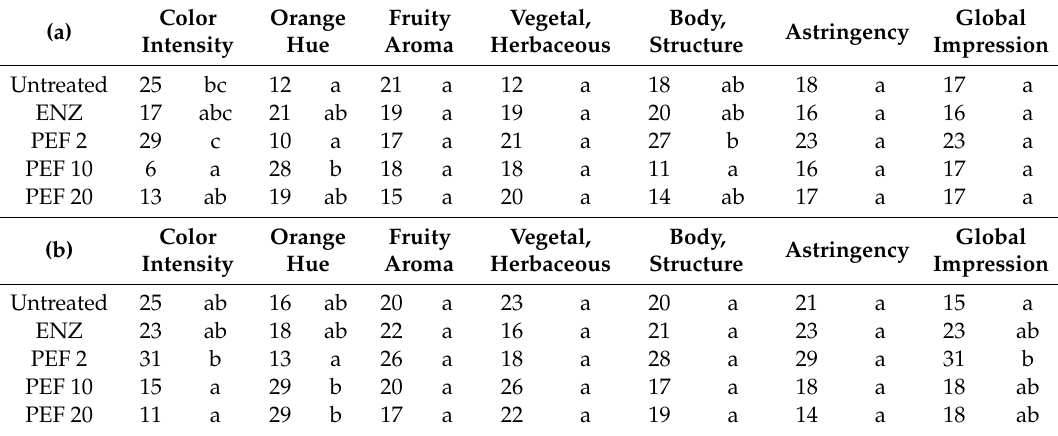
Table 5. Results of the sensory evaluation carried out on experimental wines after two ( a ) and twelve months ( b ) of bottle storage. The data reported are the sums of the ranks calculated for each sample after the ranking test. The lower the sum of the ranks calculated for a sample, the higher the intensity perceived by the panel for the attribute considered. Di ff erent letters mark significant di ff erences according to the Friedman test ( p < 0.05). Refer to Table 1 for sample